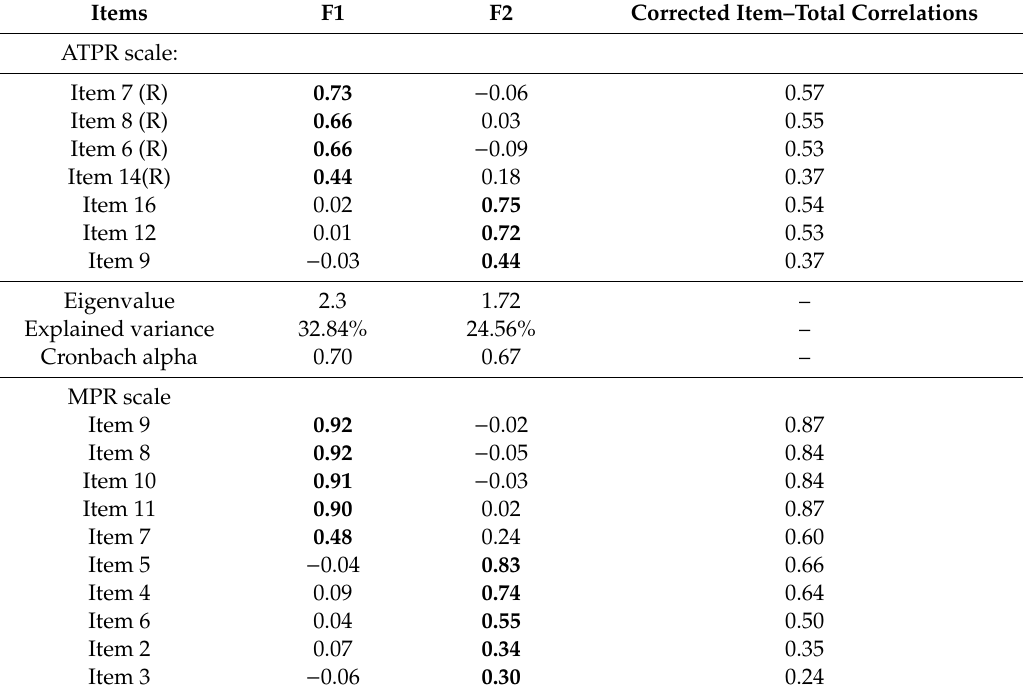
Corrected Item–Total